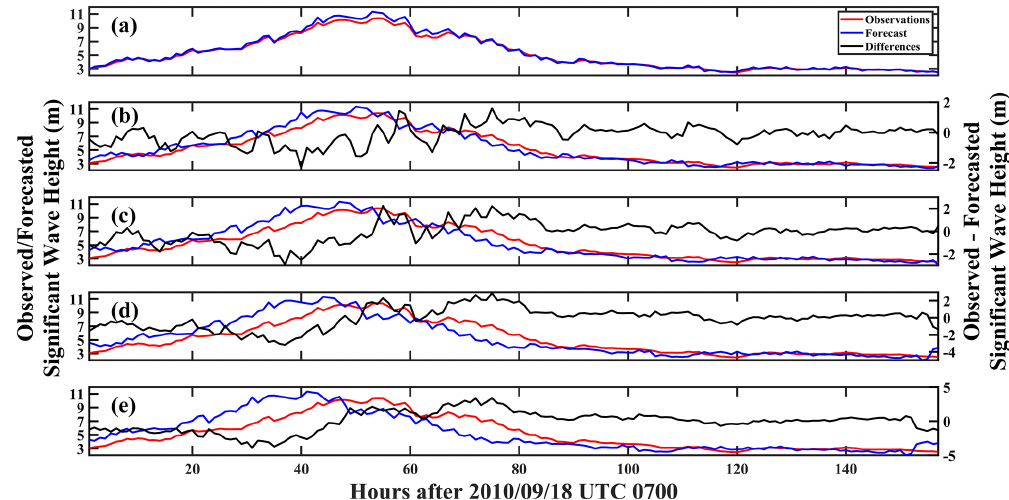
Figure 5. Same as Fig. 3, but for Hurricane Igor (2010) measured at buoys 41048 and 41049.